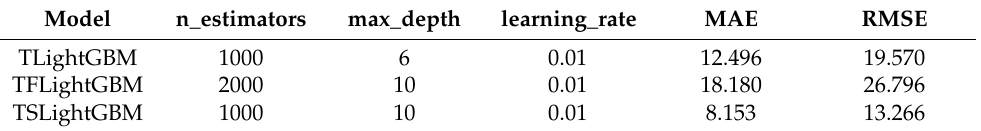
Table 4. The final adjustment results of LightGBM and the corresponding MAE and RMSE.